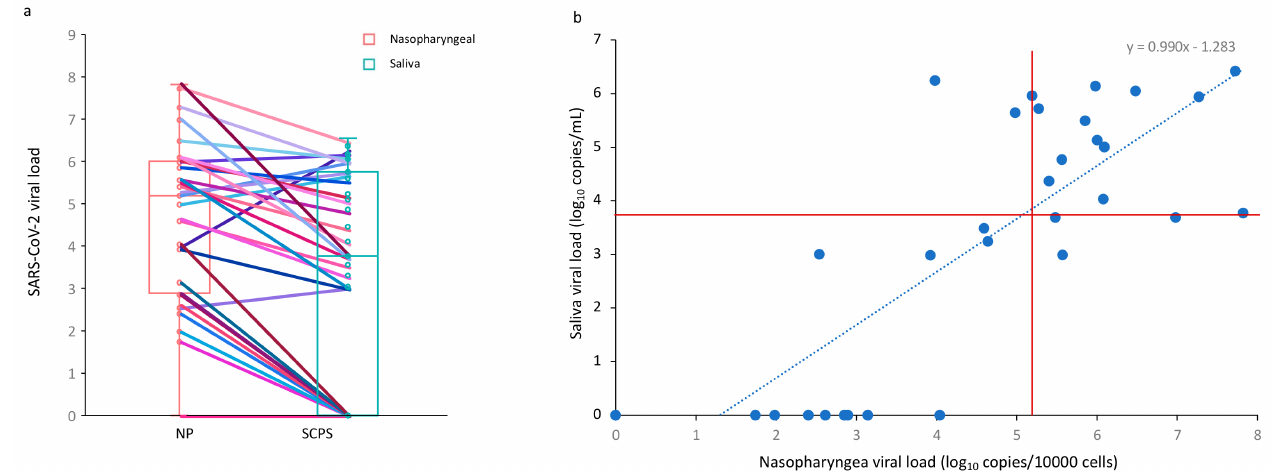
Figure 1. Analysis of SARS-CoV-2 viral load in nasopharyngeal (log 10 copies/10,000 cells) and saliva (log 10 copies/mL) samples. ( a ) Repartition of SARS-CoV-2 values for nasopharyngeal and saliva specimens. Pairs for each subjects are connected by lines; ( b ) SARS-CoV-2 values by testing concordance. The saliva SARS-CoV-2 value was set to 30 for samples in which only the nasopharyngeal target was detected. Red horizontal and vertical lines indicate the median. The median for each group was 5.27 log 10 copies/10,000 cells and 3.69 log 10 copies/mL for nasopharyngeal and saliva samples, respectively. NP, nasopharyngeal; SCPS, self-collected pure